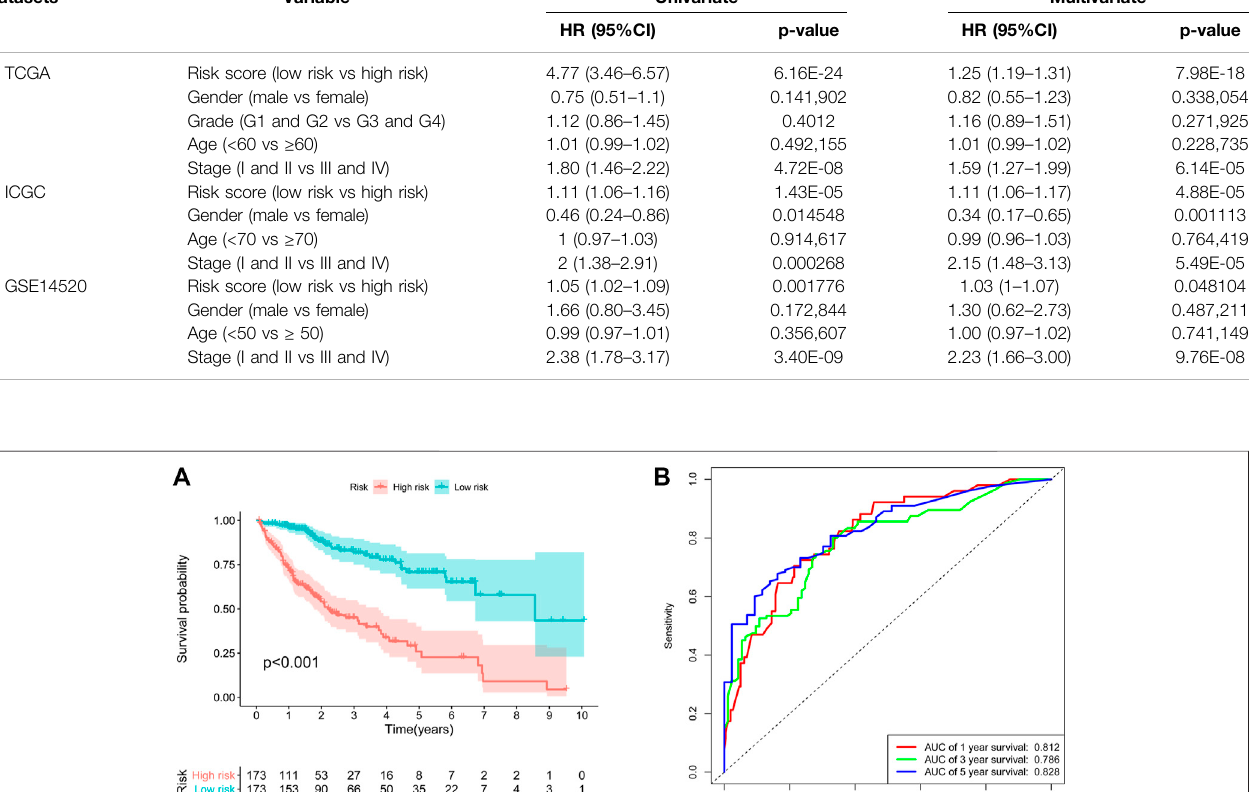
Frontiers in Molecular Biosciences |